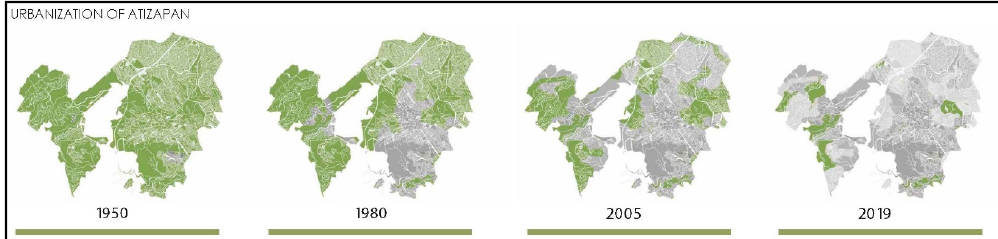
Figure 2. Urbanization process of Atizapán de Zaragoza 1950–2019; green-natural areas; grey-urbanized areas (by authors with data from PMDU 2015, [44]).